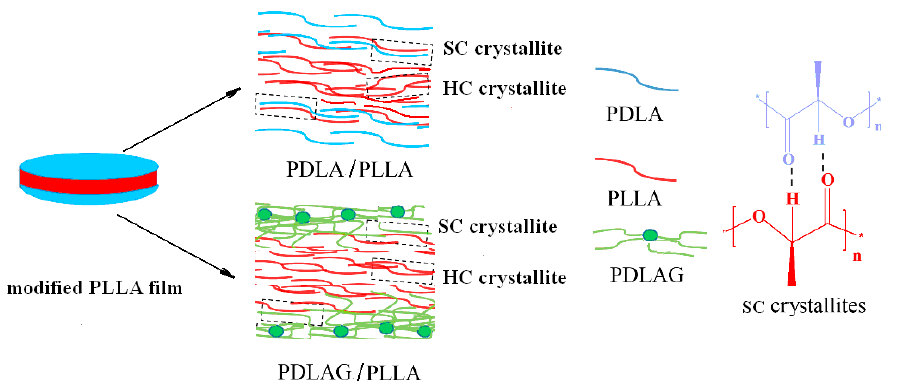
Figure 1. Structural schematic of modified PLLA film. Table 1. Modification time of PLLA films modified by PDLA and PDLAG.